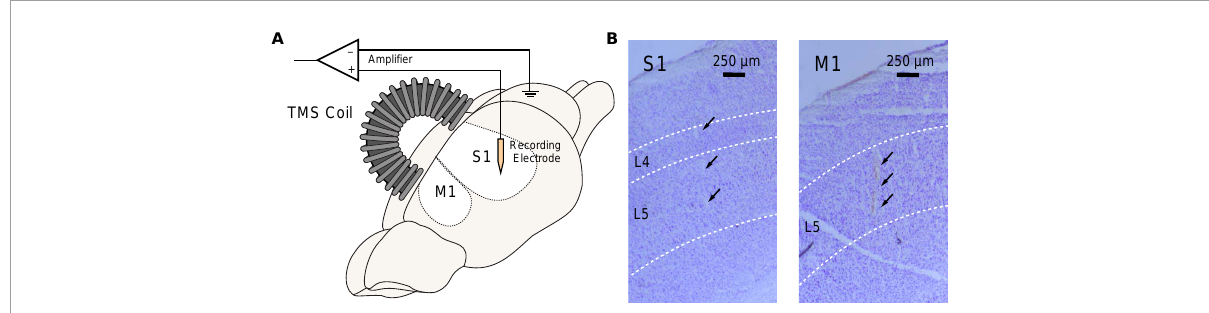
FIGURE2 Simultaneous rTMS and intracranial electrophysiological recording in rat sensorimotor cortex. (A) TMS coil was positioned above the skull and parallel to the midline with an incidence angle of 15 ◦ . A 64-channel silicon probe was implanted to the primary somatosensory (S1) or motor cortex (M1). (B) Locations of silicon probes were verified in brain slices with cresyl violet (Nissl) staining. Probe tracks were identified at layer 4–5 of the S1 (left) or layer 5 of the M1 (right).